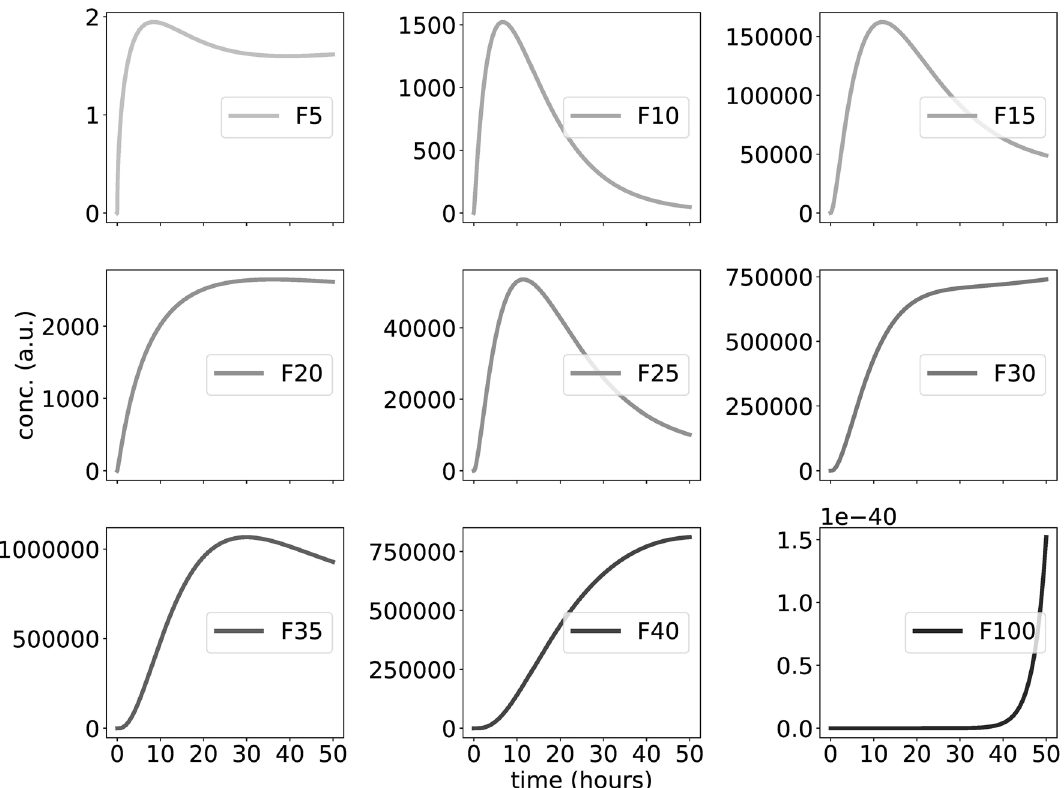
Figure 7. Large-scale simulations of nonlinear, random phosphorylations: Graphs show time-courses of hypo, medium, hyperphosphorylated and fully phosphorylated F proteins for up to n = 100 phosphorylation sites. Note, that the dashed line in Fig. 1 (inactivation of F due to phosphorylations) is adapted from 1—F40 from this